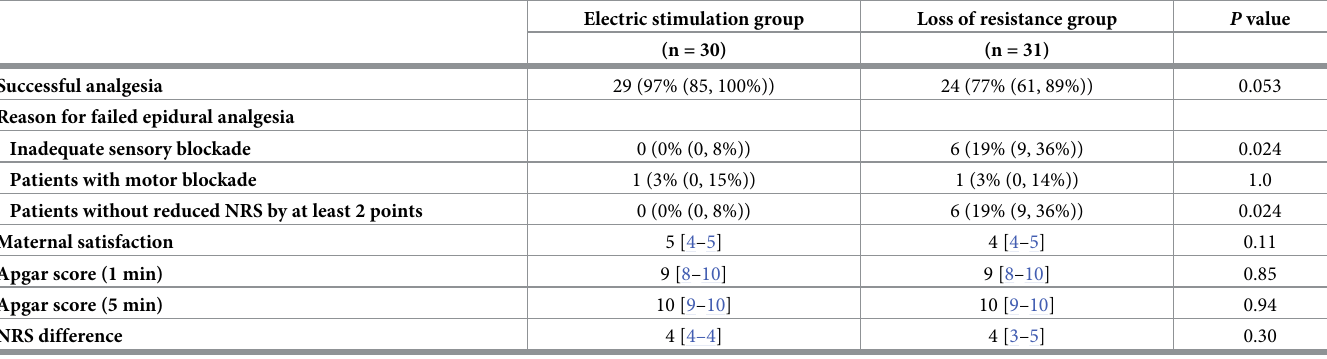
Table 2. Clinical outcomes in the epidural electric stimulation and loss of resistance